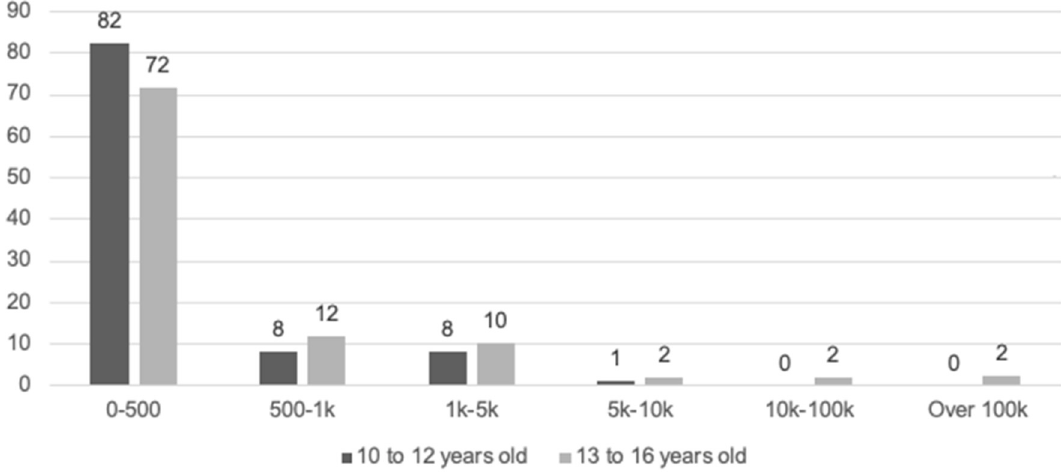
Figure 4. Number of followers on TikTok (in percentage).